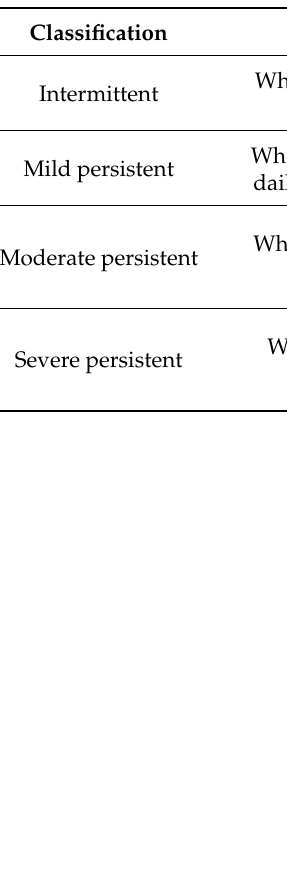
Table 2. Asthma classification and treatment in patients ≥ 12 years of age.